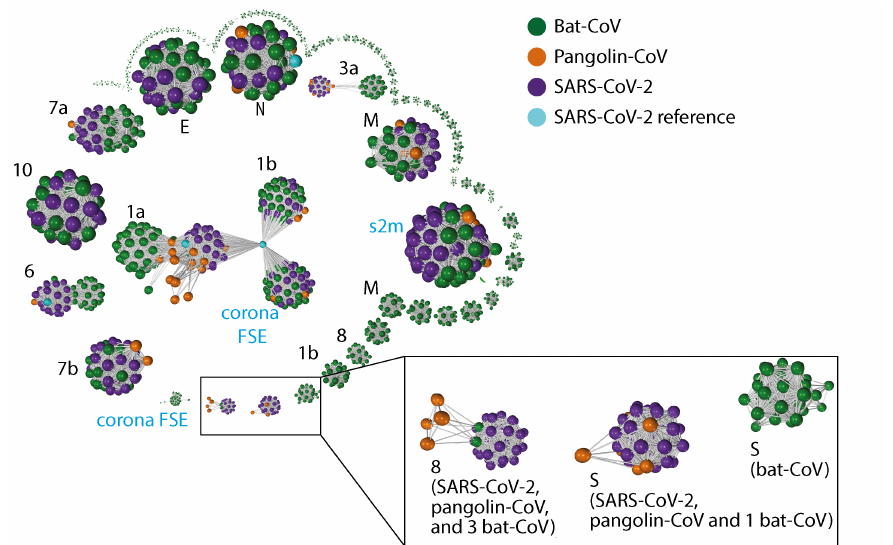
Figure 2. Gene–gene similarity network analysis. Each node represents a gene defined by PROKKA or a DNA segment similar to genes from the SARS-CoV-2 reference genome. The nodes were compared against each other using BLAST, and nodes with high similarity (bit score ≥ 60 and a query coverage ≥ 80%) were connected with an edge. The network graph is labelled with host species. The black font in the graph indicates the corresponding SARS-CoV-2 gene names (“Open Reading Frame (ORF)” omitted) for the larger clusters, whereas blue font indicate additional non-coding sequences defined by PROKKA. Instead of the full length ORF1ab ( 21kb in length), ORF1a and ORF1b were defined by PROKKA as two separate genes. Notably, ORF1a, ORF3a, ORF6, and ORF8 and S show strong separations between nodes from different species. ORF8 from 3 bat-CoV co-clusters with ORF8 from SARS-CoV-2 (bat-RaTG13, bat-SL-CoVZC45 and bat-SL-CoVZXC21, respectively). The remaining bat-CoV ORF8 do not co-cluster with SARS-CoV-2 ORF8 even without the edge filtering threshold. For S, the bat-RaTG13 co-cluster with COVID-19 and pangolin. A cluster of bat-CoVs break off for ORF1b and M, suggesting a large amount of variation amongst bat-CoV for these